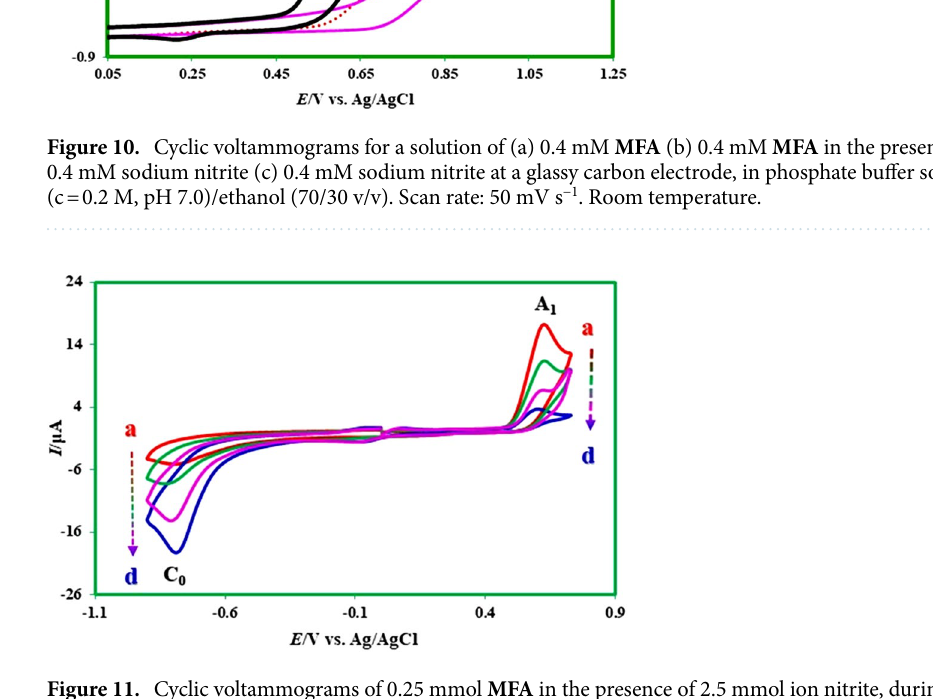
Figure 11. Cyclic voltammograms of 0.25 mmol MFA in the presence of 2.5 mmol ion nitrite, during controlled potential coulometry at 0.5 V versus Ag/AgCl. After consumption of: (a) 0, (b) 35, (c) 70 and (d) 100 C in Scan rate 50 mV s −1 ; Room temperature.